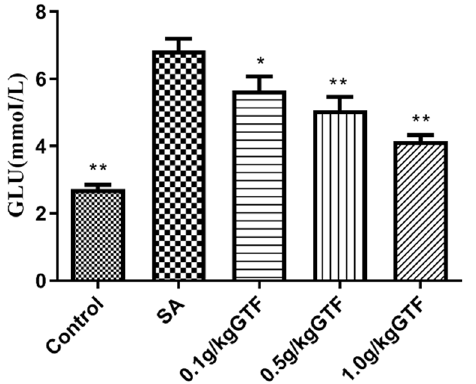
Figure 4. Effects of GTF on GLU level in the serum of tilapia. Values are expressed as the mean ± ( n = 10). * p < 0.05; ** p < 0.01, compared with the control SEM ( n = 10). * p < 0.05 ; ** p < 0.01, compared with the control group.